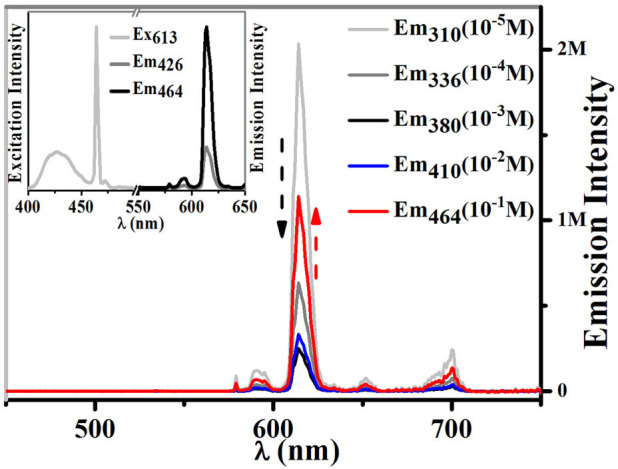
Emission spectra of 1 with different concentrations in CH2Cl2 at 298 K.